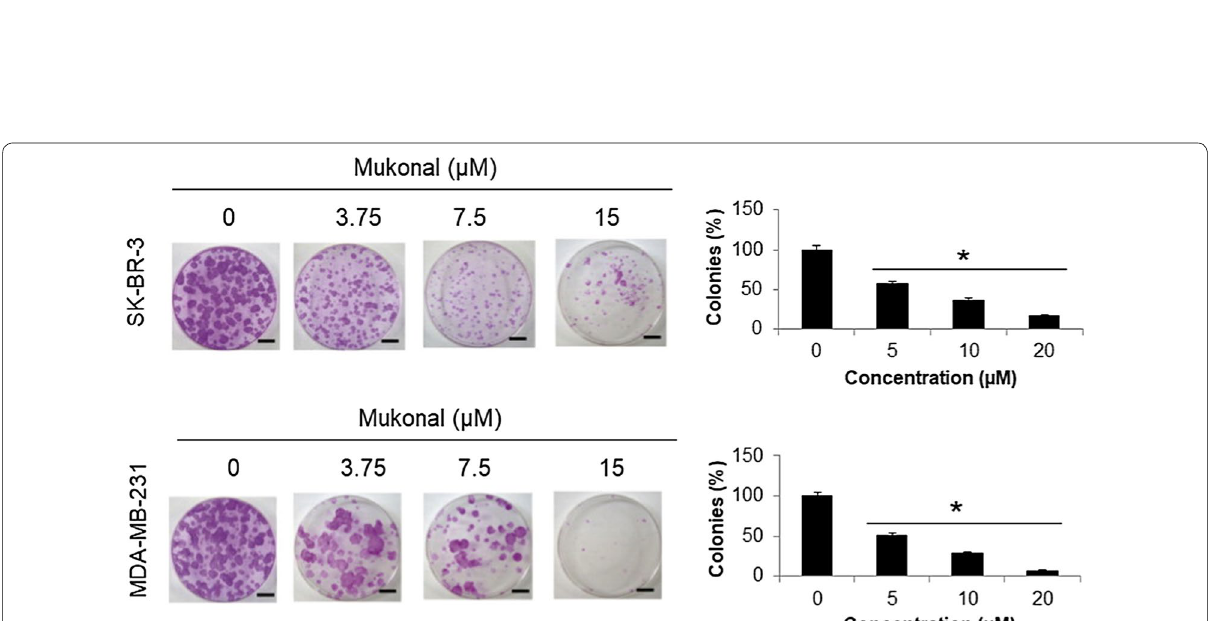
Fig. 2 Clonogenic analysis of MDA-MB-231 and SK-BR-3 cells after being exposed to indicated mukonal doses. MDA-MB-231 and SK-BR-3 breast tumor cell lines were treated with mukonal, left untouched for 10 days and stained with crystal violet to calculate the number of colonies generated provided considering colonies with > 50 number of cells for calculation. All the experiments were executed three times and data was shown as mean SE (standard error). The p value of < 0.05 was taken as a statistical significant ±